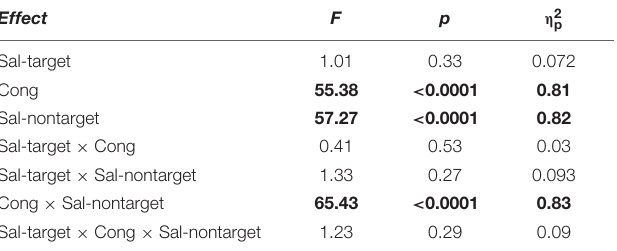
TABLE 4 | ANOVA results on error rates for auditory task.